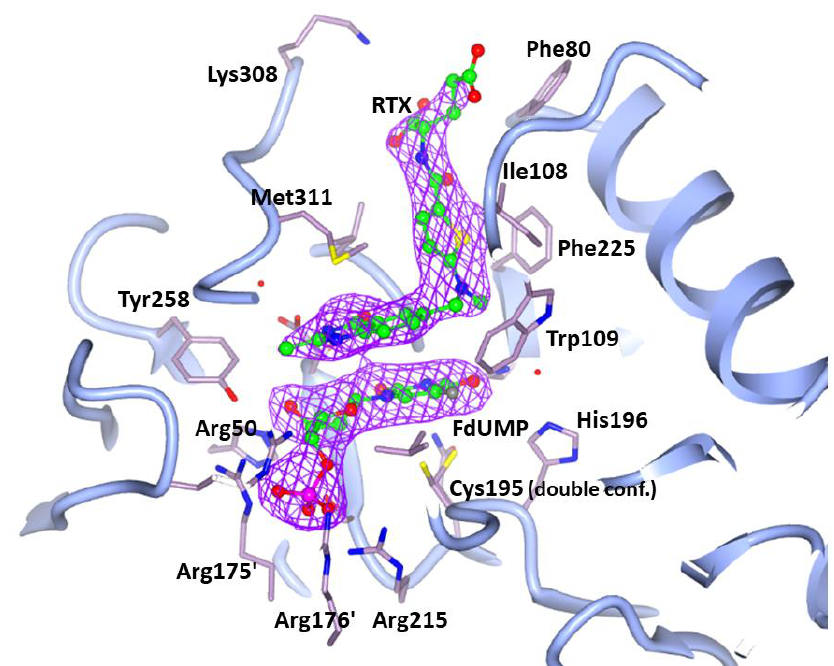
Figure 2. Unbiased omit map (purple mesh) contoured at 3.5 σ, showing the two inhibitors FdUMP and RTX (balls and sticks, green carbons) bound to the hTS active site (light blue cartoon, residues in sticks, lilac carbons) and their positions with respect to Cys195 (modeled in two alternate conformations, one pointing towards the pyrimidine ring and the other one pointing towards the opposite direction, both not bound to FdUMP) and the other key neighboring residues within the enzyme catalytic cavity, such as Trp109. Nitrogen, oxygen, and sulfur atoms are shown in the conventional blue, red, and yellow colors. Phosphorus and fluorine atoms are displayed as magenta and gray spheres, respectively.